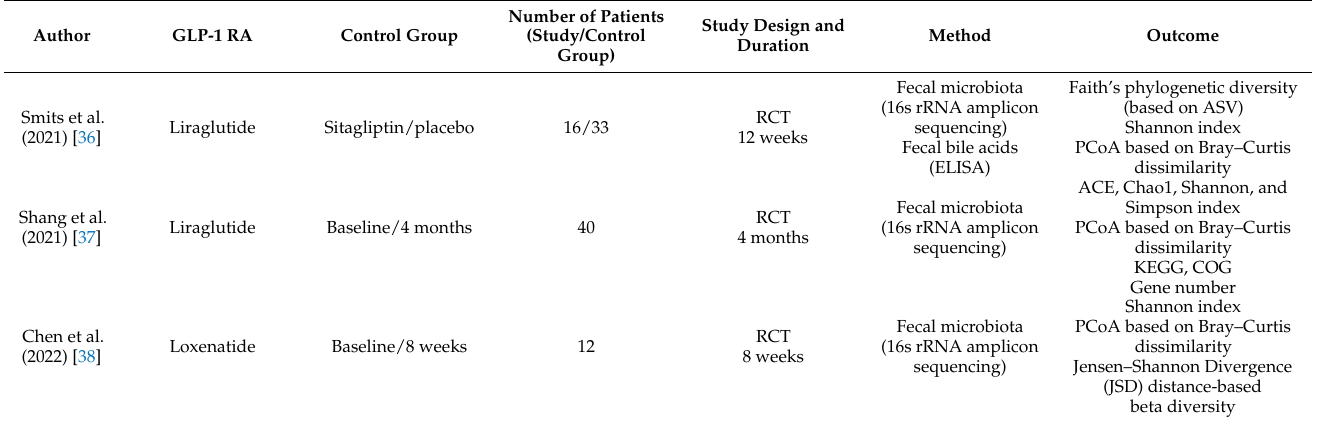
Table 2. GLP-1 RA effect on microbiota in